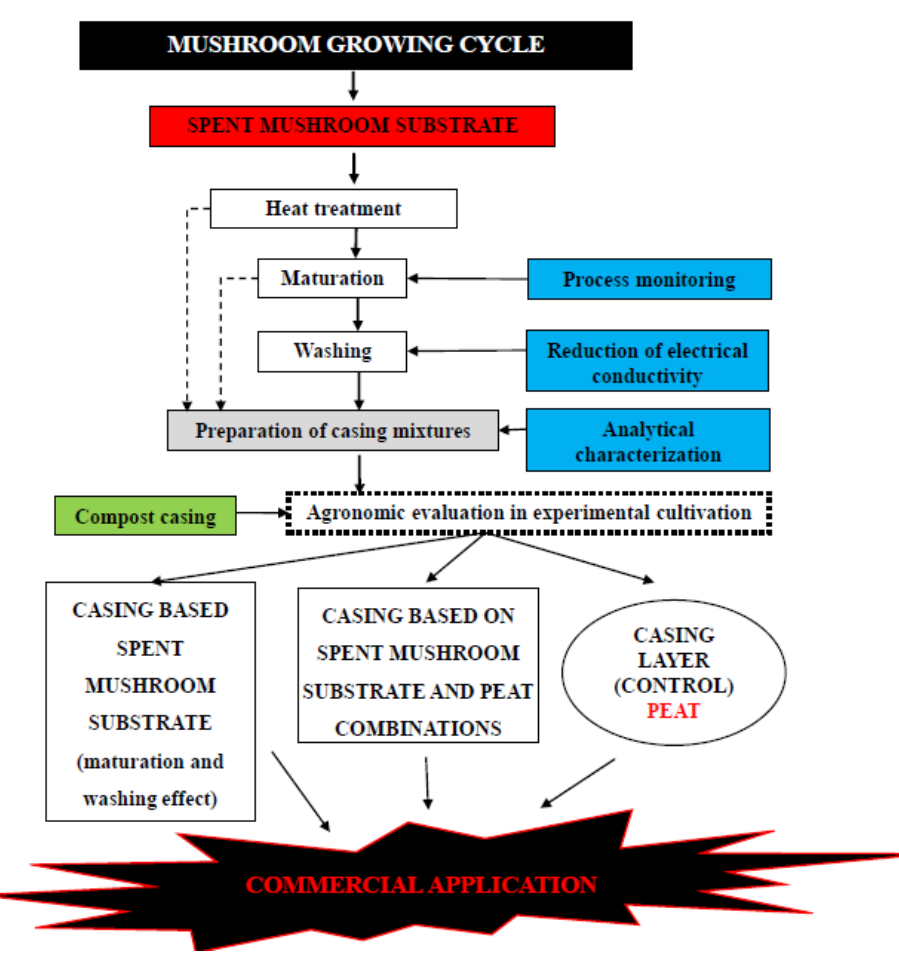
Figure 3. Steps that must be followed carefully before applying SMS as a casing layer.